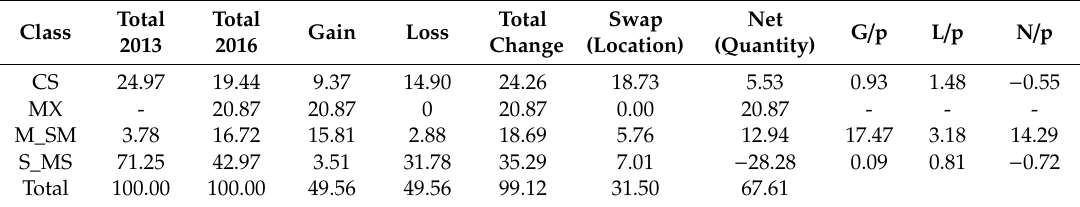
Table 5. Change detection statistics for the habitat classes of the Chioggia 2013 and 2016 study